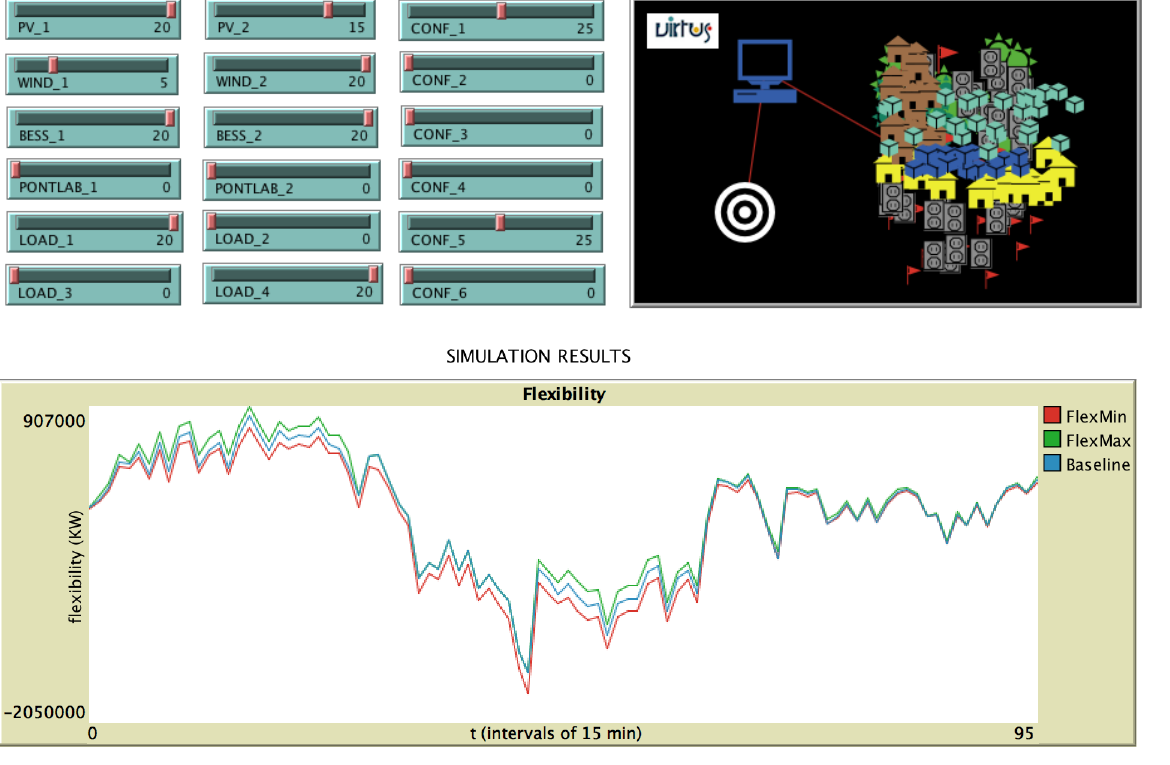
Figure 18. ( Up ) Case study 2 setting. ( Down ) Case study 2